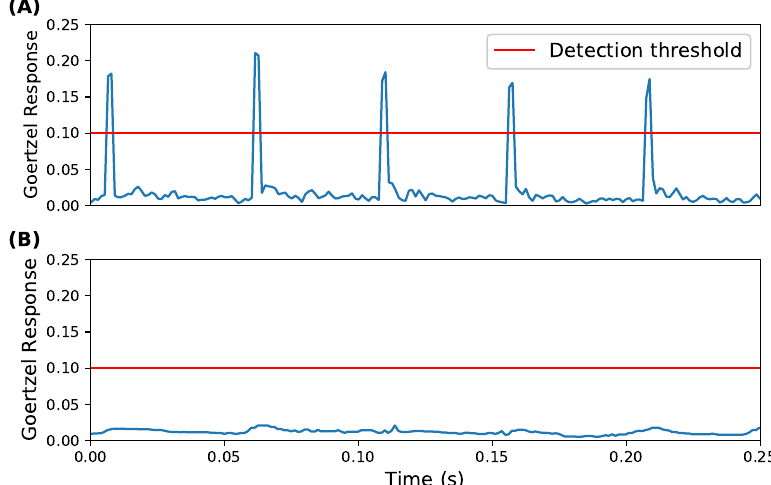
Figure 4. Bat detection analysis on a recording of a soprano pipistrelle bat, collected by a deployed AudioMoth device. The two plots each show median responses of two sliding windows, ( A ) with the correctly configured five Goertzel outputs per window; and ( B ) with too many, at 15 per window. Bat calls are missed when over half the windows consist of background noise, rather than the call